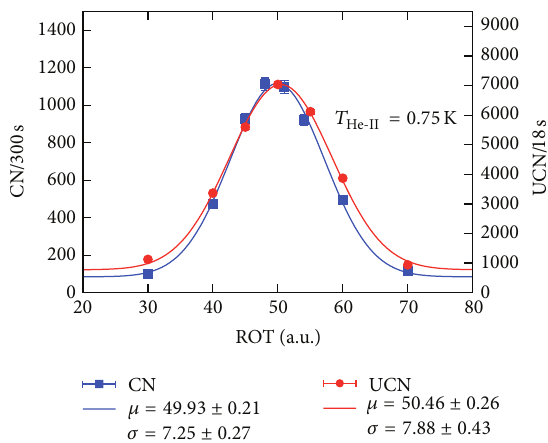
Figure 3: Neutron rate as a function of the monochromator rotation angle, for UCNs (dots) and cold neutrons